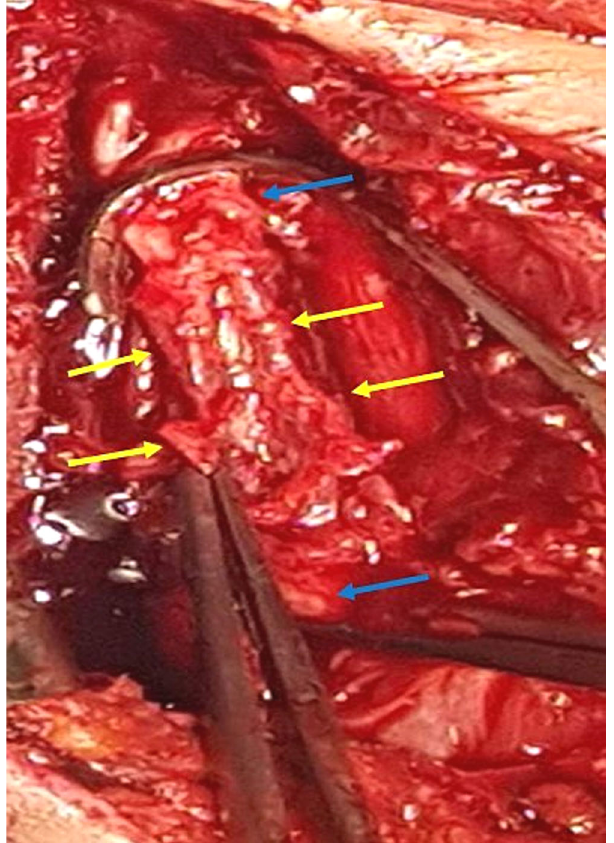
Figure 3. Preoperative view, the CCA was dissected and controlled and clamped at its origin and terminated just before the carotid bifurcation (blue arrow). Mycotic aneurysm, and all-around infected tissues were resected (yellow